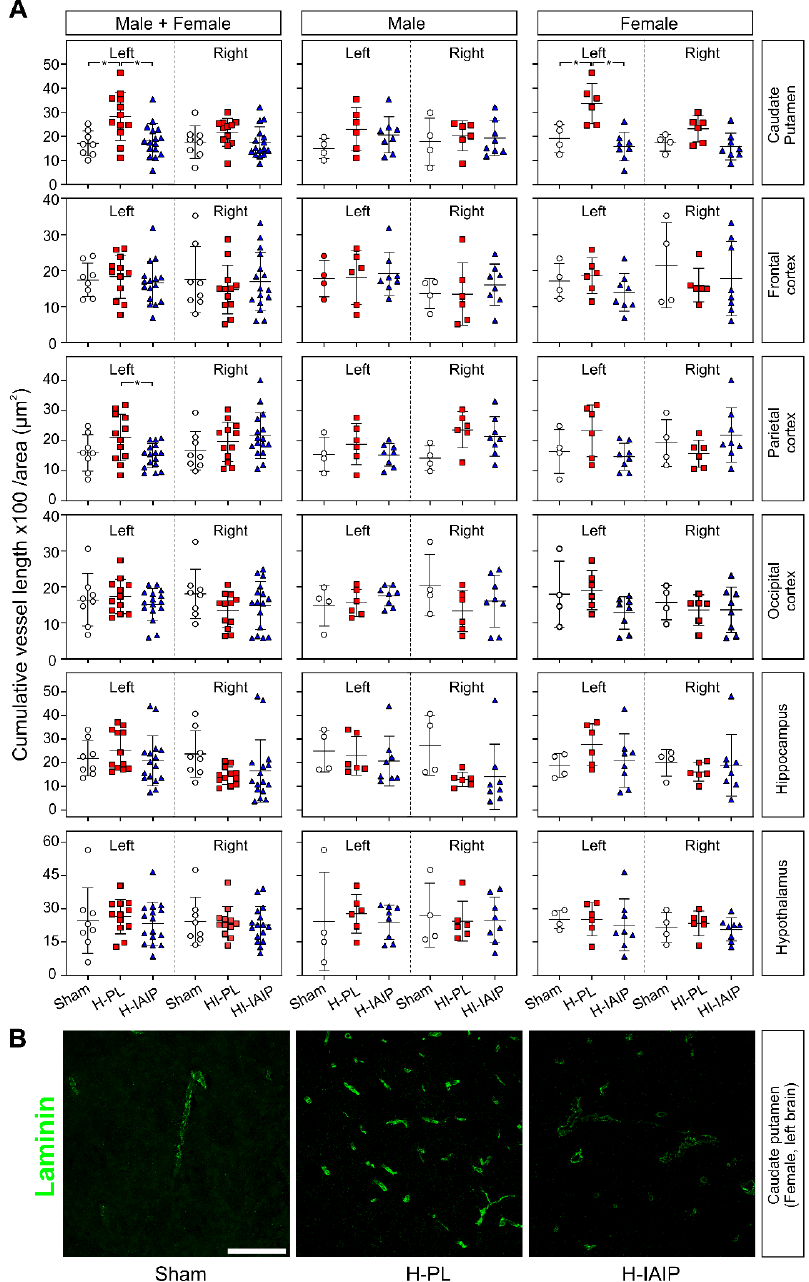
Figure 2. The effects of systemic treatment with hIAIPs on cumulative vessel length in neonatal rats exposed to systemic hypoxia (H, left side of the brain) and hypoxia – ischemia (HI, right side of the brain). ( A ) Quantification of the vessel length parameters in the total group of males + females and separately for the male and female pups. Data are mean ± SD. Male: sham = 4, H - PL/HI - PL = 6, H - IAIP/HI - IAIP = 8. Female: sham = 4, H - PL/HI - PL = 6, H - IAIP/HI - IAIP = 8. * p ≤ 0.05 for indicated comparisons. ( B ) Representative confocal microscopy images of H - left caudate - putamen nuclei immunostained for laminin in the female rats. Treatment with hIAIPs (H - IAIP) reduced the increased cumulative vessel length observed after exposure to hypoxia to the amounts observed in sham - operated animals (sham). Scale bar: 100 µm.